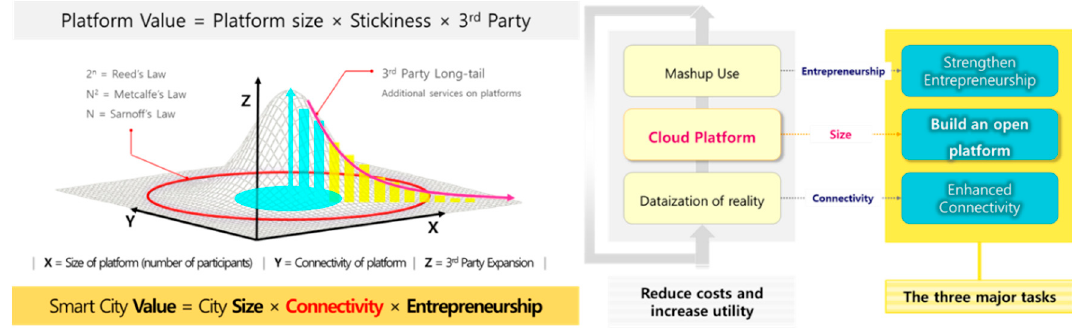
Figure 6. Smart City Value Model and 3 elements in building a Smart City.